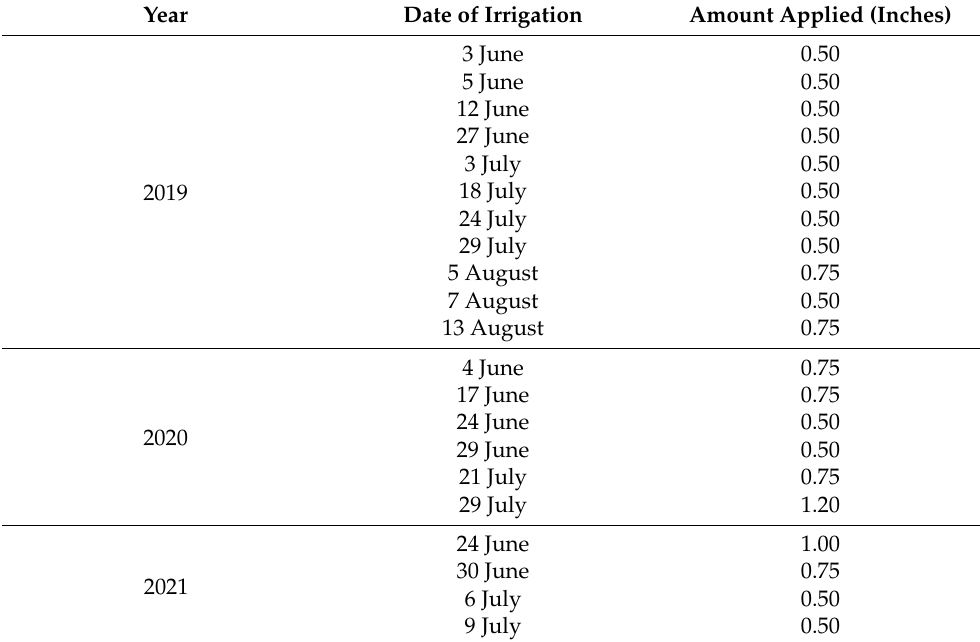
Table 3. Irrigation dates and applied amount (inches) in each year from 2019 to